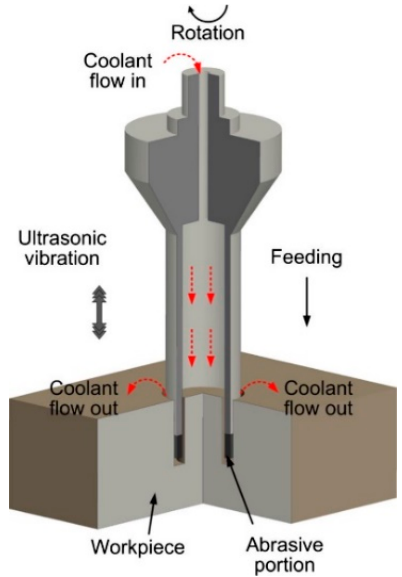
Figure 5. Cross-sectional view of the machined sample for optimum solution [17]. Another innovative machining process applied to CFRP is rotary ultrasonic machining (RUM), a hybrid grinding process aided by ultrasonic vibration of the order of 20 kHz, in which the coolant removes the chips and prevents overheating. Ning et al. [65] compare drilling of CFRP parts by conventional twist drill method and RUM. The cutting force, torque, surface finish, hole diameter, and material removal rate are analyzed in this work. The cutting forces found are consistently lower for RUM, although the difference is smaller at higher speeds. Also, for higher rotational speeds, the cutting force, torque, surface roughness, and hole diameter are lower. There are no significant differences in MRR between the two technologies. One of the drawbacks of RUM is the need for a significant initial investment in machinery and tooling, but the cost of the tool is cheaper because of reduced tool wear. The study’s overall conclusion indicates a higher efficiency of the RUM process, including better cutting forces, lower torques, and better surface qualities. Figure 6 shows the schematic of a state-of-the-art ultrasonic RUM machining process applied to FRPs.